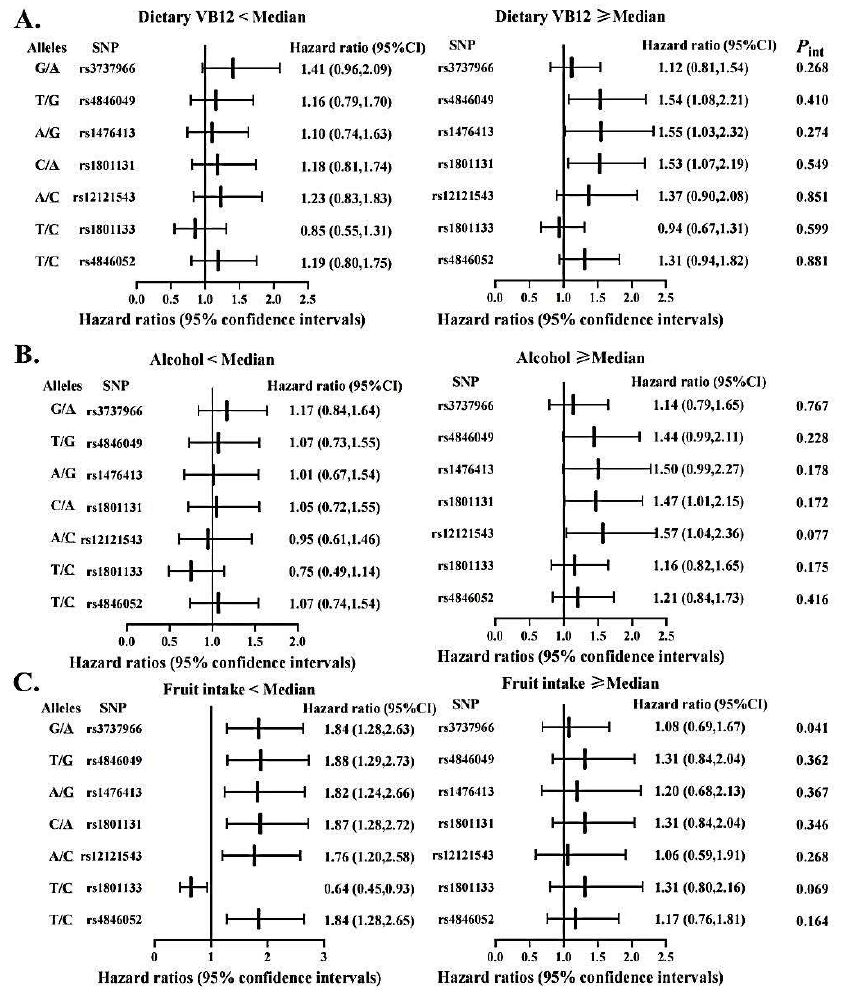
Figure 4. Association between selected genetic variations in MTHFR and CRC overall survival stratified by dietary vitamin B12 ( A ), alcohol intake ( B ), and fruit consumption ( C ). Abbreviations: SNP = single nucleotide polymorphisms. Two variants at the locus presented as: Minor/Major allele. Hazard ratios were calculated in reference to the allele underlined. Cox proportional hazard models were adjusted for age at diagnosis, sex, stage at diagnosis, race, BMI, BRAF2, smoke status, marital status and MSI status, where appropriate. The medians of dietary vitamin B12, alcohol drinking, and fruit intake were 7.30 µ g/day, 2.17 g/day, and 7 pieces/week,